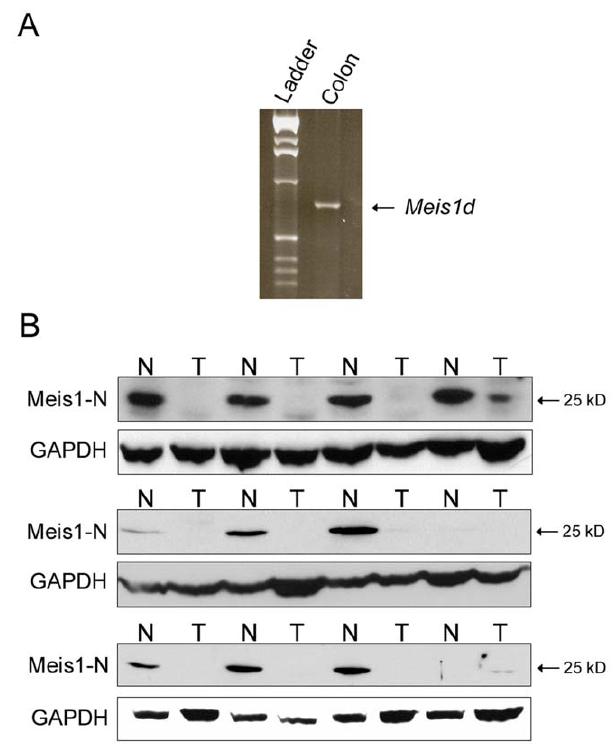
Figure 5. MEIS1D 27 is downregulated in human colorectal cancers. A) RT-PCR amplification of MEIS1D transcript from human colon cDNA. B) Western blot analysis of lysates from human colorectal tumors (T) and matched normal mucosa (N) using the Meis1-N antibody. GAPDH was used as a loading control. Samples represent all four sections of the human colon: ascending, transverse, descending, and sigmoid.